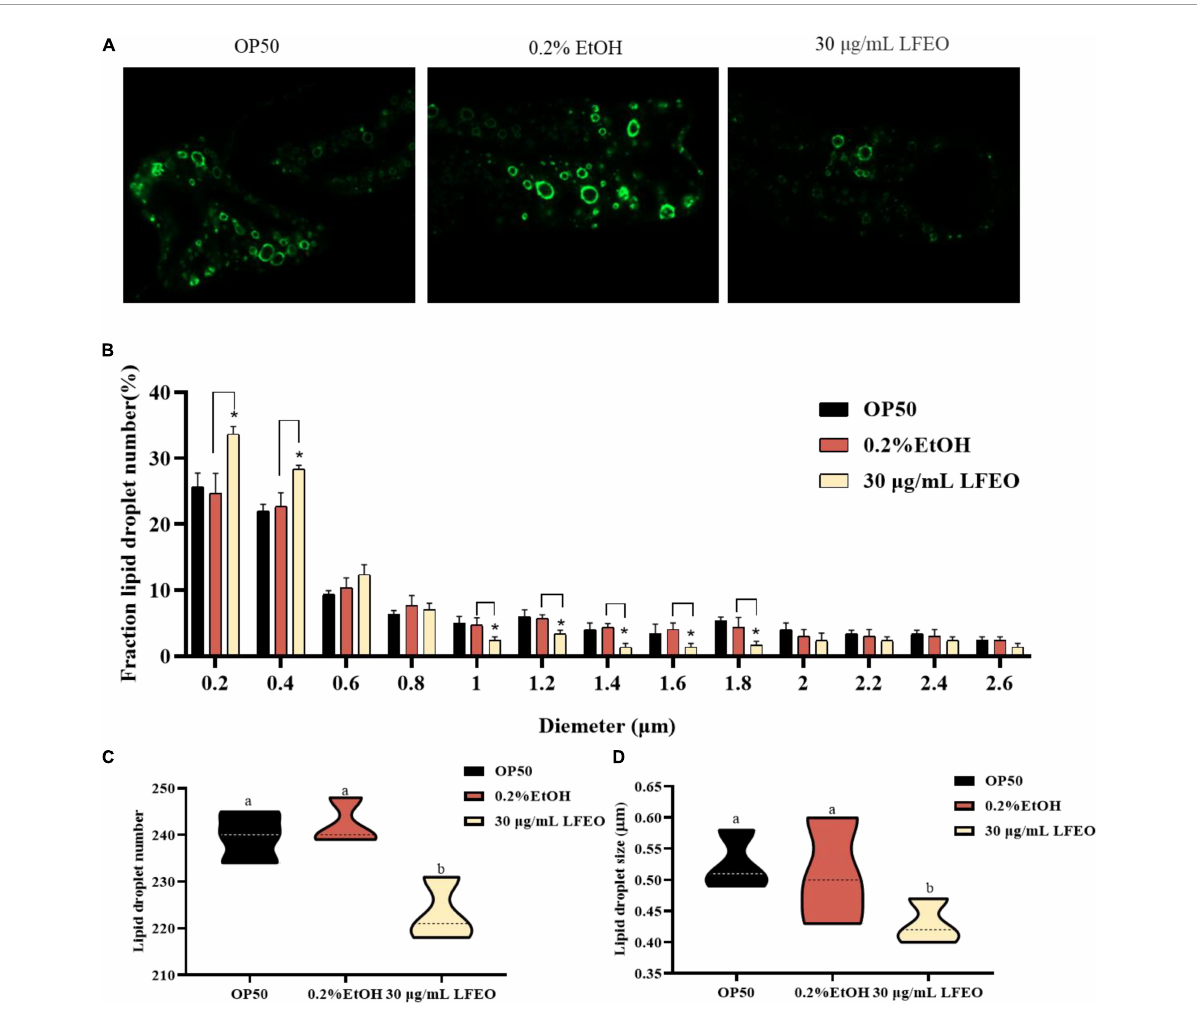
FIGURE4 Effect of litchi flower essential oil (LFEO) on the number and diameter of lipid droplets in mutant ZXW618. (A) Representative fluorescence images of ZXW618 worms treated without or with 30 µ g/mL LFEO. (B) Distribution of different size lipid droplets in ZXW618. (C) Average number of lipid droplets in ZXW618. (D) Average diameter size of lipid droplets in ZXW618. Statistical analysis of the results was done using a one-way ANOVA with Bonferroni tests as post hoc comparison; different letters indicate a significant difference, p < 0.05, with at least 15 worms per